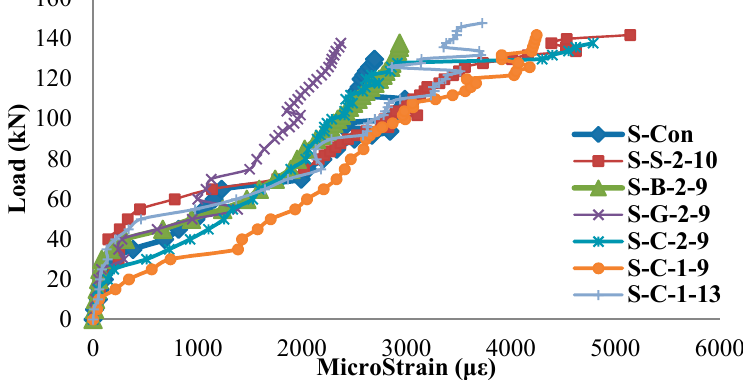
Figure 13. Applied load vs. maximum tensile strain in longitudinal reinforcement.